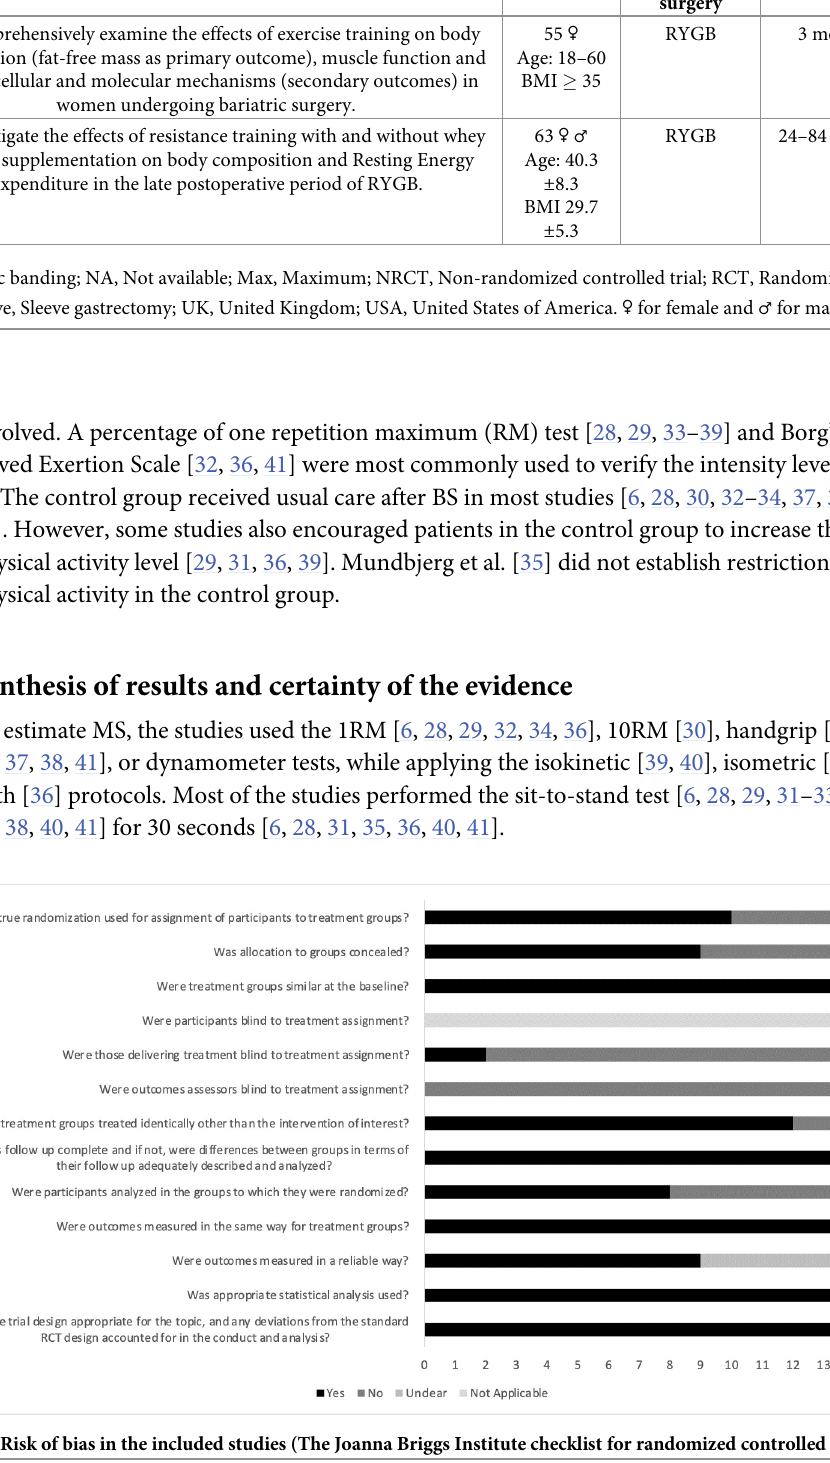
To comprehensively examine the effects of exercise training on body composition (fat-free mass as primary outcome), muscle function and related cellular and molecular mechanisms (secondary outcomes) in women undergoing bariatric surgery. To investigate the effects of resistance training with and without whey protein supplementation on body composition and Resting Energy Expenditure in the late postoperative period of RYGB.